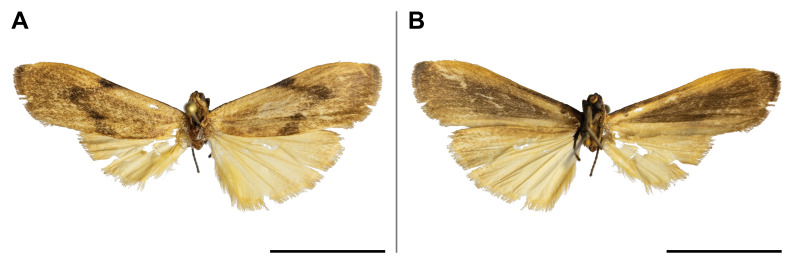
Archithosia
makomensis (Strand, 1912). A. dorsal view; B. ventral view. The scale bar represents 1 cm.